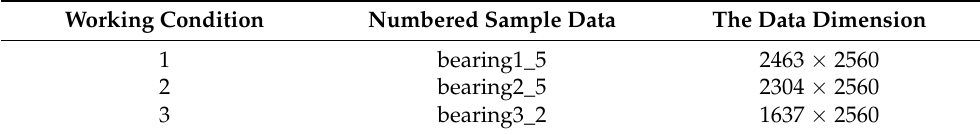
Table 3. Selected experimental datasets in different working conditions.